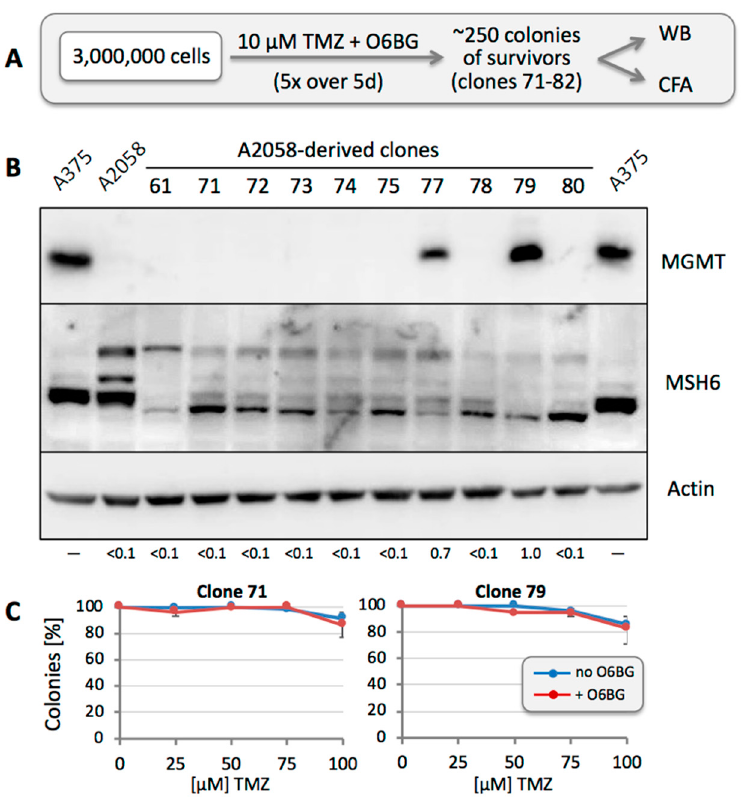
Figure 9. Drug resistance after repeated low-dose TMZ plus O6BG treatment. ( A ) Treatment schedule was as follows: 3 × 10 6 A2058 cells were seeded into a 25-cm plate and treated with 10 µM TMZ in the presence of O6BG once daily over 5 days. After about 15 days, there were approximately 250 colonies, which were pooled and expanded. After sufficient proliferation, 3 × 10 6 of these cells were seeded again into a 25-cm plate and exposed to a single treatment of 100 µM TMZ in the presence of O6BG. Another 15 days later, approximately 2000 colonies emerged, which were sub-cultured to allow for the isolation of 12 individual clones (numbered 71 through 82), which were analyzed by WB and CFA. ( B ) Cell lysates were prepared from all clones and analyzed by WB for MGMT and MSH6 protein levels. Lysates from A375 and A2058 cells were included for comparison. (Clones 81 and 82 are not included in this figure; clone 76 was lost.) Numbers under the blot indicate quantification of MGMT bands, with reference to the actin signal, and relative to Clone 79 (set at 1.0); <0.1 indicates below detection limit. ( C ) To confirm drug sensitivity in correlation with MGMT or MMR deficiency, clones 71 and 79 were treated with increasing concentrations of TMZ in the presence or absence of O6BG, and CFA was performed 12 days later ( n = 3, ±SE).